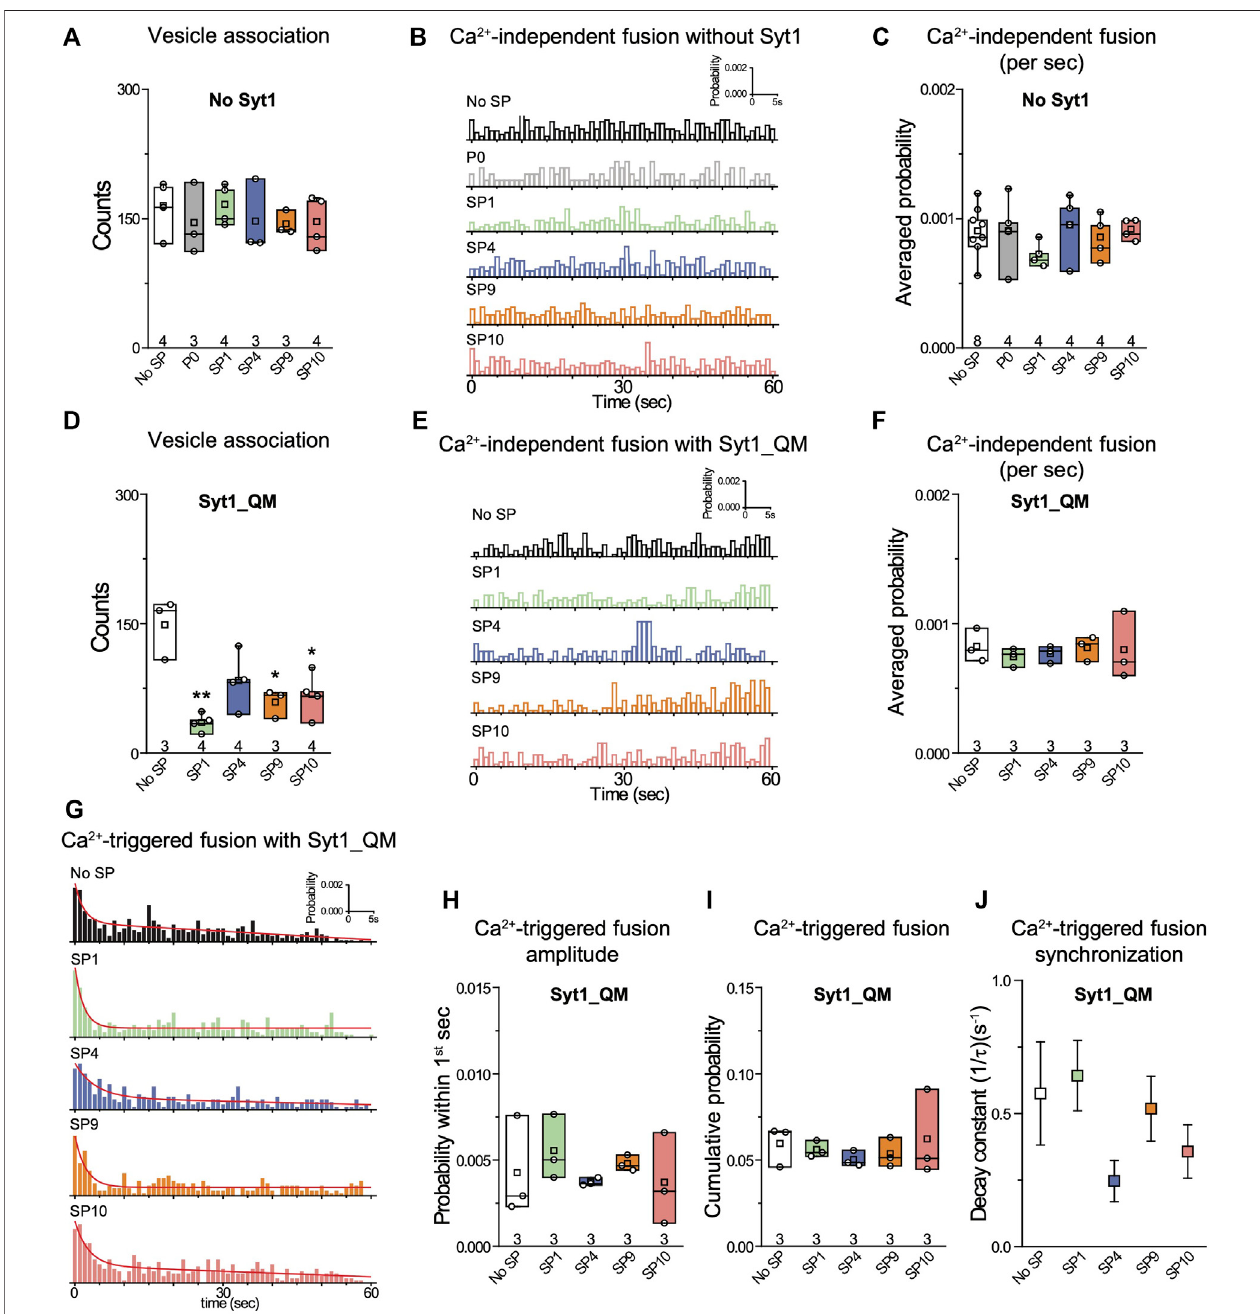
FIGURE 4 | The quintuple Syt1_QM mutant and omission of Syt1 alleviate the inhibitory effects of stapled peptides. (A) Effects of 10 μ M of each of the speci fi ed peptides on vesicle association. (B) Corresponding Ca 2+ -independent fusion probabilities. (C) Corresponding average probabilities of Ca 2+ -independent fusion events per second. (D) Effects of 10 μ M of each of the speci fi ed peptides on vesicle association (left to right: ** p = 0.0016, * p = 0.016, * p = 0.017). (E) Corresponding Ca 2+ - independentfusionprobabilities. (F) CorrespondingaverageprobabilitiesofCa 2+ -independentfusioneventspersecond. (G) CorrespondingCa 2+ -triggeredfusion probabilities. (H – J) Corresponding Ca 2+ -triggered fusion amplitude of the fi rst 1-s time bin upon 500 μ M Ca 2+ -injection (H) , the cumulative Ca 2+ -triggered fusion probability within 1 min (I) , and the decay rate (1/ τ ) of the Ca 2+ -triggered fusion histogram (J) . The fusion probabilities and amplitudes were normalized to the number of analyzedneuronalSV — neuronalPMvesiclepairs( SupplementaryTableS1 ).Panels A , C , D , F , H , I showboxplotsanddatapointsforn(indicatedbeloweachboxplot) independent repeat experiments ( Supplementary Table S1 ): the whiskers show the min and max values (excluding outliers), the box limits are the 25th and 75th percentiles, the square point denotes the mean value, and the center line denotes the median. Decay constants (boxes) and error estimates (bars) in panel J computed from the covariance matrix upon fi tting the corresponding histograms combining all repeats with a single exponential decay function using the Levenberg-Marquardt algorithm. * p < 0.05, ** p < 0.01 by Student ’ s t-test, compared to the experiment without the stapled peptides.